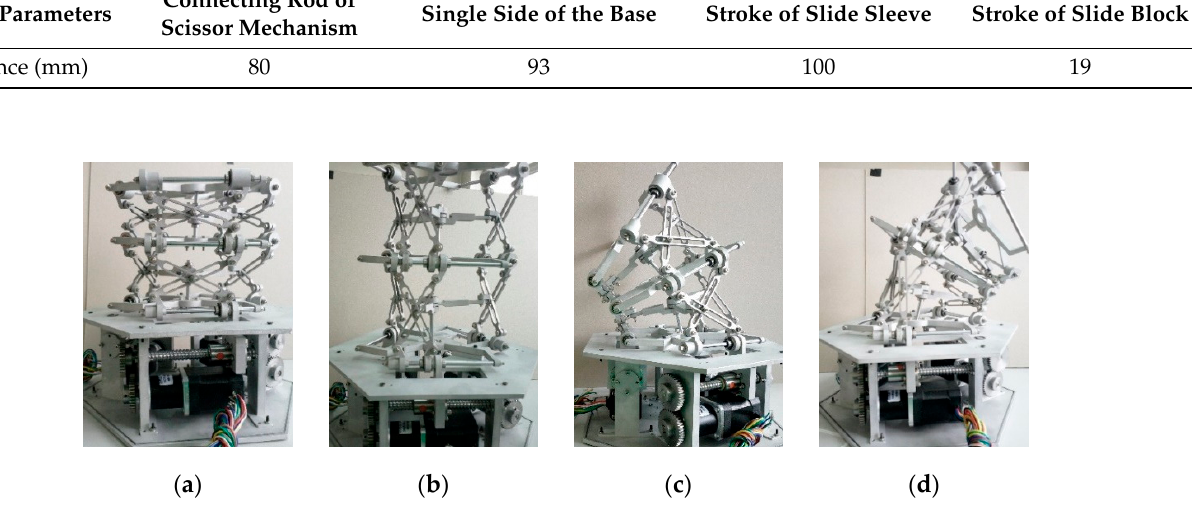
Figure 7. Prototype of the space continuous robot: ( a ) initial contraction state, ( b ) stretch state, ( c ) ultimate bending state (left), and ( d ) ultimate bending state (right). Table 2. Design parameters of scissor mechanism unit.